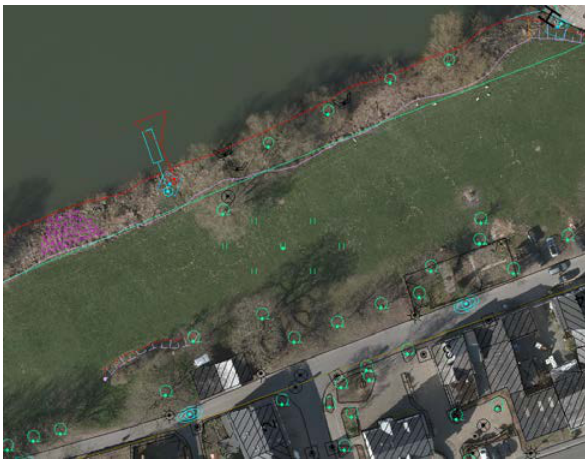
Fig. 7: Geometric quality check by superimposition of vector data